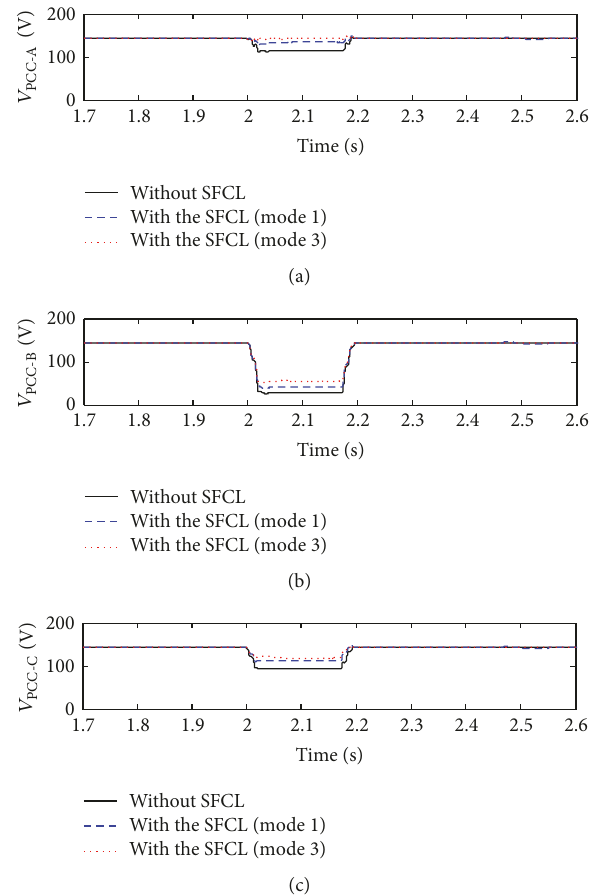
Figure 19: Influence of the active SFCL on the PCC voltage under the asymmetrical